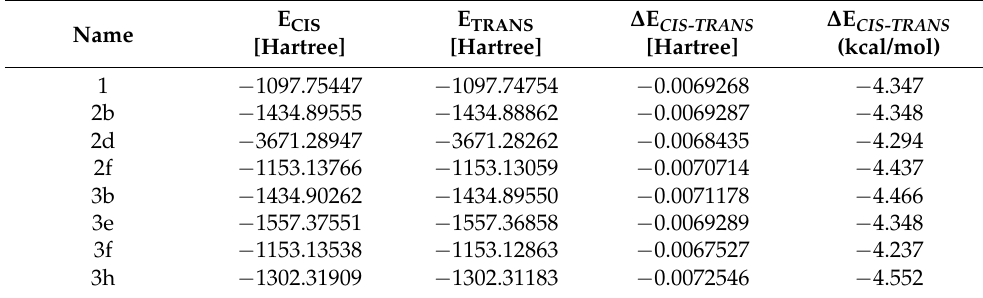
Table 6. Energies of cis- and trans -isomers of 5-nitroisatin-based benzoylhydrazines estimated in DMSO at the B3LYP/6-311 ++ G(d,p) level of theory. ∆ E CIS-TRANS represents the difference between cis- and trans- isomers ( ∆ E CIS-TRANS = E CIS − E TRANS ).